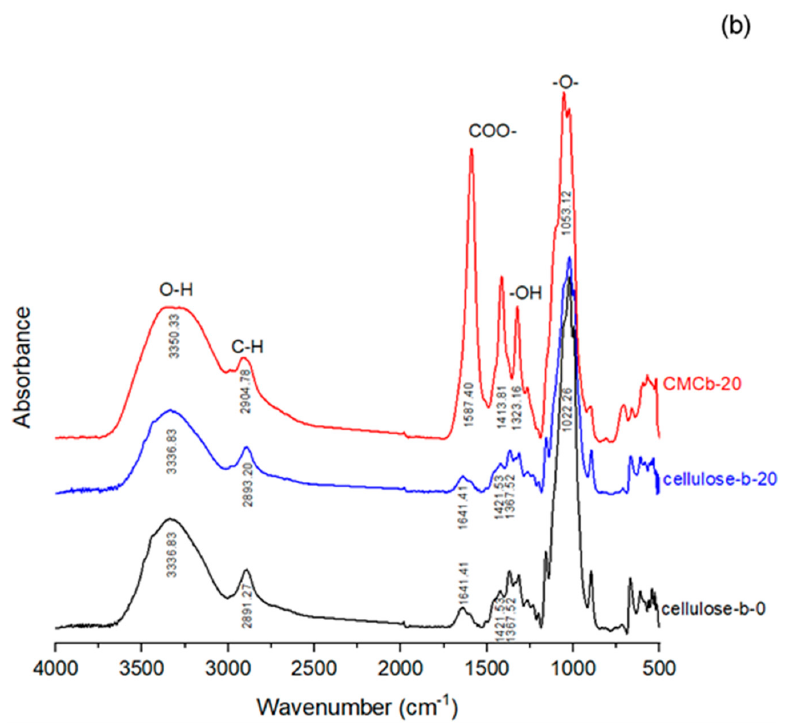
Figure 6. FTIR spectra of cellulose and CMC from ( a ) palm bunch and ( b ) bagasse.